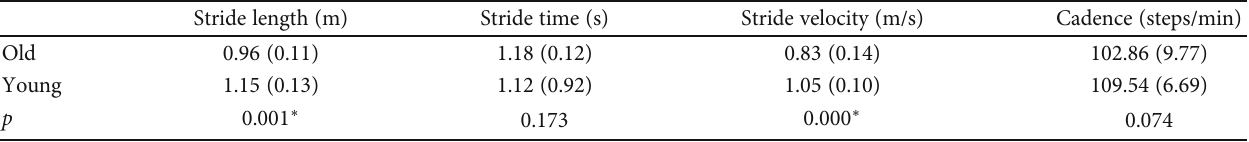
Figure 2: Reconstructed mean lateral VSTs (orange), medial VSTs (blue), and mean projection pathways to PIVC (green) for the two study groups. Table 3: Comparison of spatiotemporal parameters between young and old healthy adults during tandem gait.